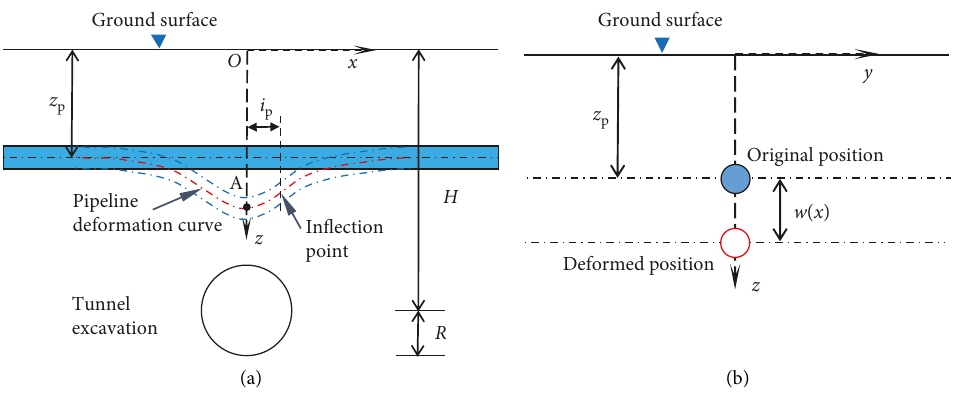
Figure 2: Deformation calculation diagram of pipeline during tunnel excavation. (a) In the x-z plan and (b) in the y-z plan.